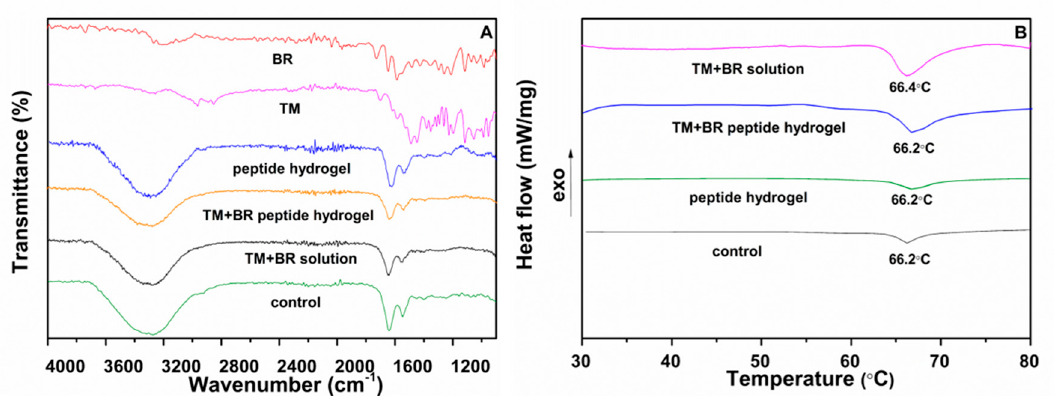
Figure 5. ( A ) FTIR spectra of pure brimonidine tartrate, pure timolol maleate and of the control cornea and the corneas treated with the peptide hydrogel, the drug solution and the drug loaded peptide hydrogel. ( B ) Thermograms of the control cornea and the corneas treated with the peptide hydrogel, the drug solution and the drug loaded peptide hydrogel.